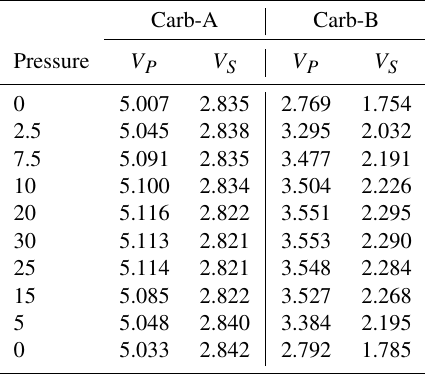
Data were further corrected considering deviation of the indenter tip from ideal geometry, initial penetration into the rock below a load threshold, and compliance of the loading column, leading to a nominal uncertainty of indentation mod- uli of < 2